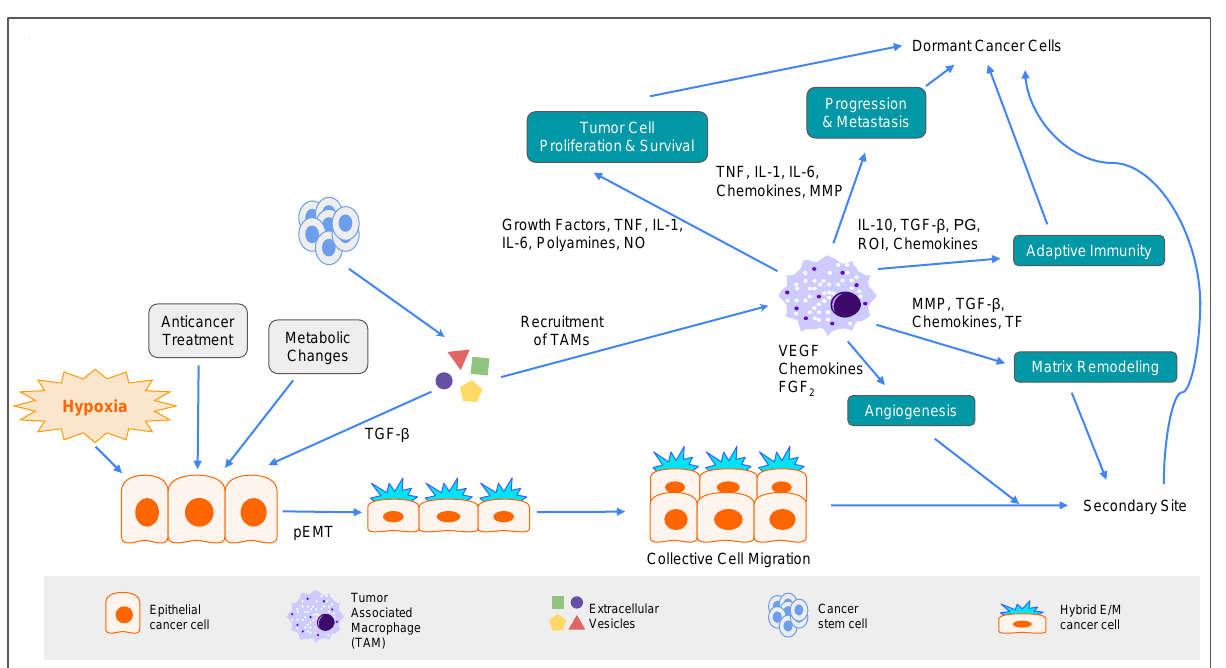
Figure 6. Cellular plasticity of tumor cells is governed by partial EMT (pEMT). Several factors are involved in the regulation of MET-pEMT-EMT transition and TME remodeling during tumor progression, including hypoxia, anticancer treatment, metabolic changes, and TGF- β secreted by cancer stem cells. These factors guide tumor cells in going into cellular transformation from an epithelial program to a partial epithelial-to-mesenchymal transition (pEMT) program. Cancer cells with the pEMT phenotype provide the necessary cell – cell contact for collective cell migration toward a secondary site. On the other hand, extracellular vesicles secreted by cancer stem cells recruit tumor-associated macrophages (TAMs), which can further assist cellular plasticity during metastasis by secreting a variety of cytokines and chemokines. Examples include angiogenesis and cluster cell migration promoted by VEGF and FGF2; TME remodeling for a protumor microenvironment by MMPs, TGF- β, and certain chemokines; cell proliferation and survival by TNF, IL -1, IL-6, polyamines, and NO; cancer progression and metastasis by TNF, IL-1, IL-6, MMPs; adaptive immunity by IL-10, TGF- β, PG, ROI, and certain chemokines; and c ancer dormancy.